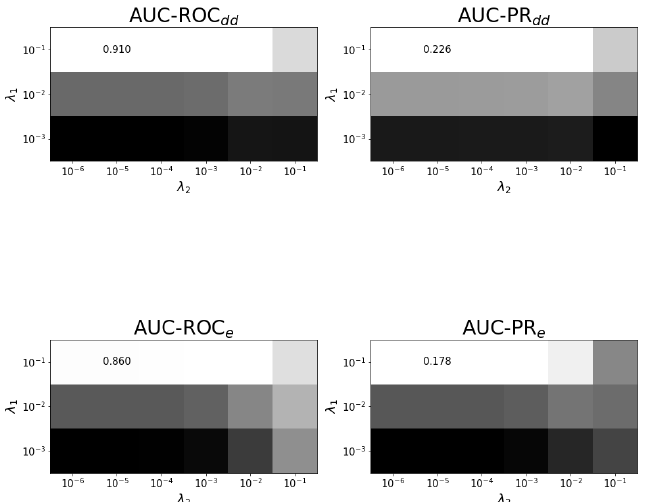
Figure A3. Tuning regularization parameters for task (cid:98) dde at optimal λ 3 . The average performance on ten training folds using shortcuts for leave-out validation is shown for different combinations of regularization parameters. The optimal combination and values are shown. White corresponds to the highest performance and black to the lowest performance. Each panel has a different color scale as performance varies over different